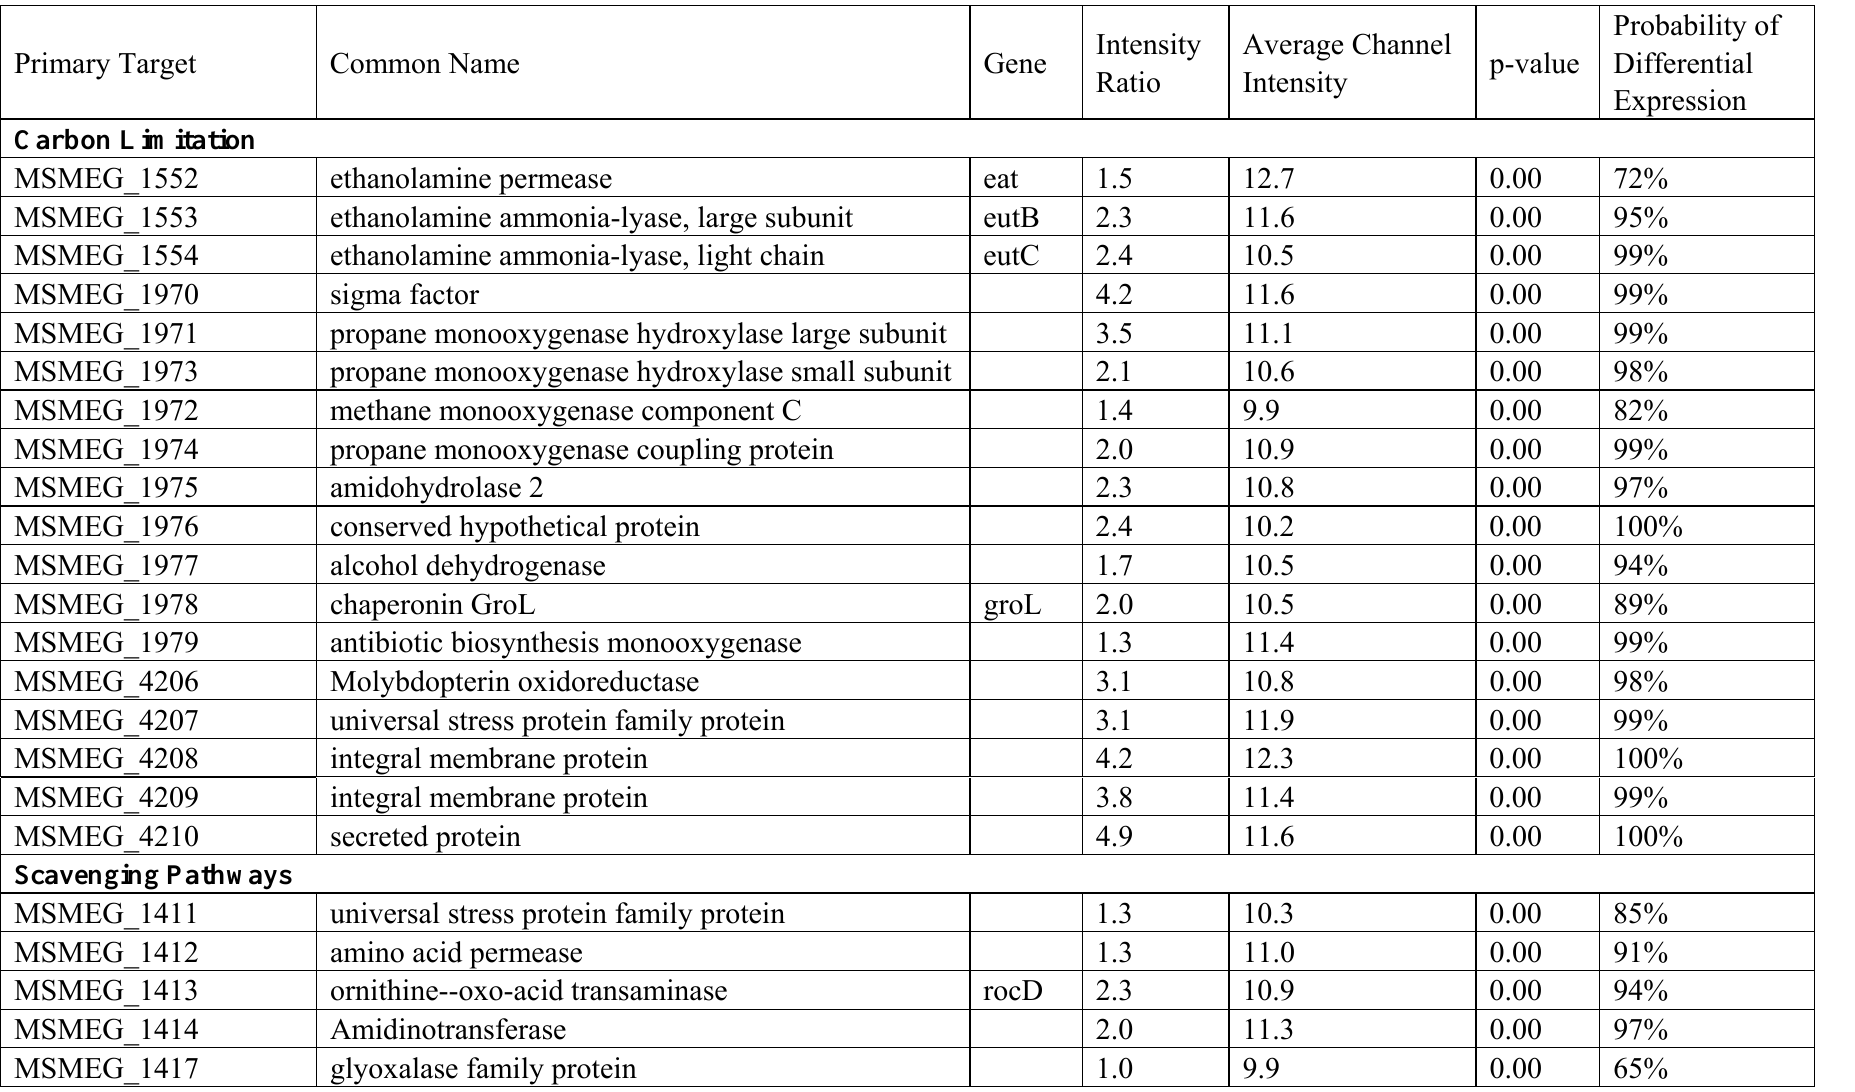
Appendix Table 3. Select up-regulated operons and clusters in stationary phase over log phase (non-spray dried log versus stationary